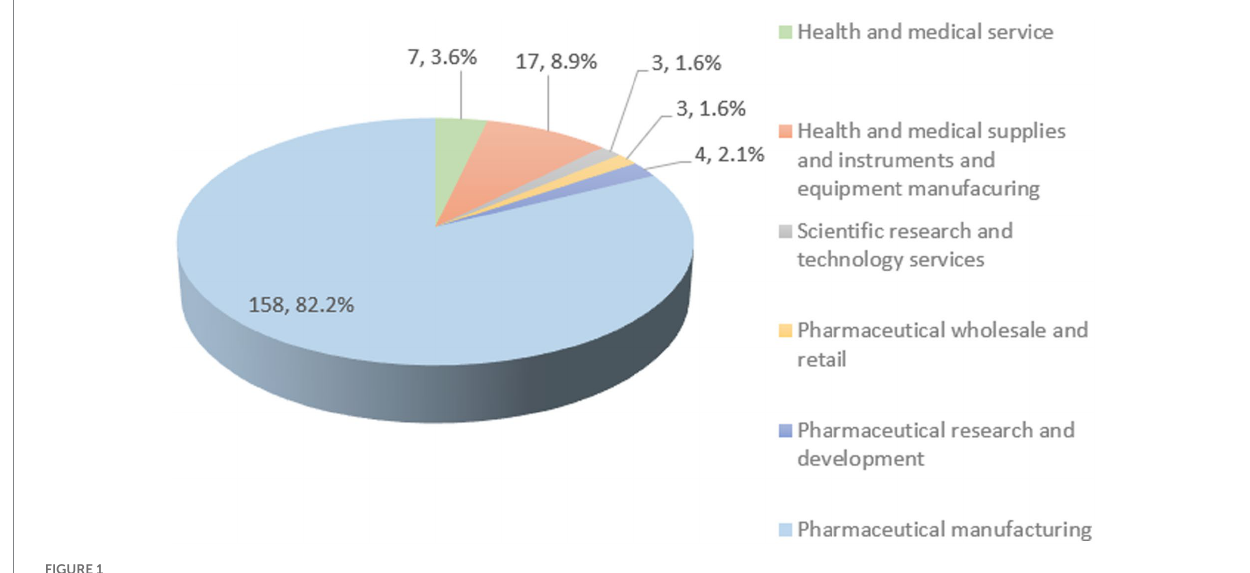
FIGURE 1 Industry distribution of 192 listed companies in the health industry in China, 2015–2020.